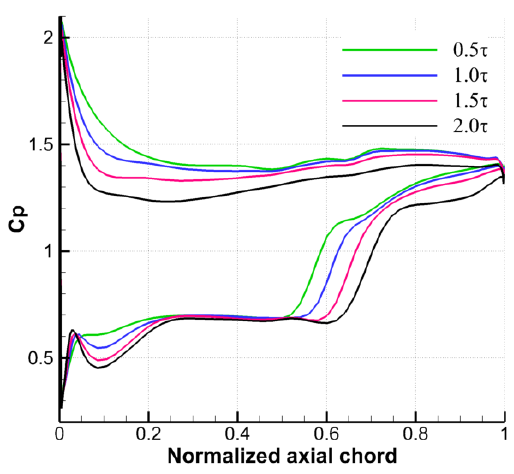
Figure 11. Relative Mach number contours on the rotor blade tip plane with different rotor tip clearances at P1.